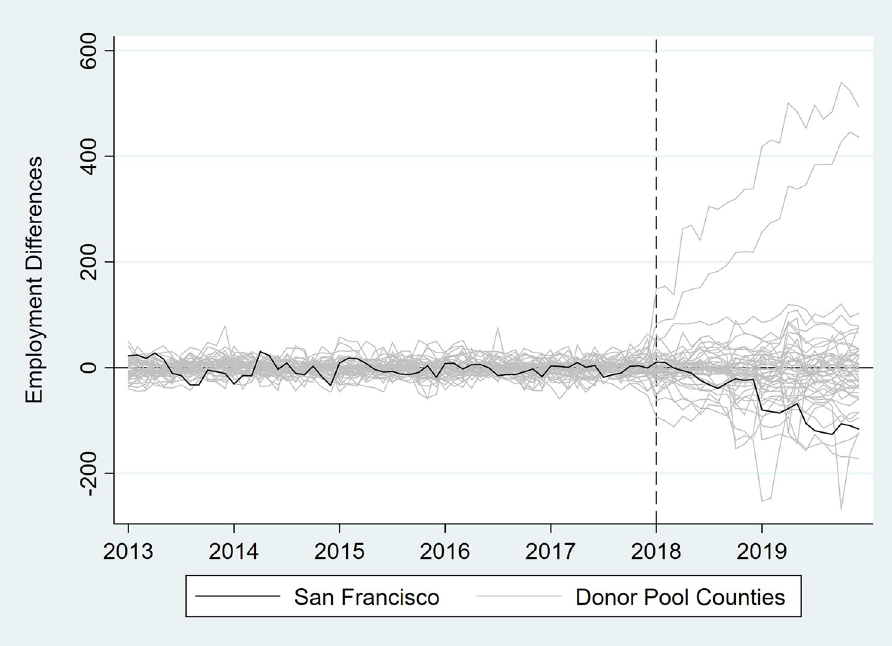
Fig 10. Differences in employment outcomes between each county and its synthetic control for convenience store employment.